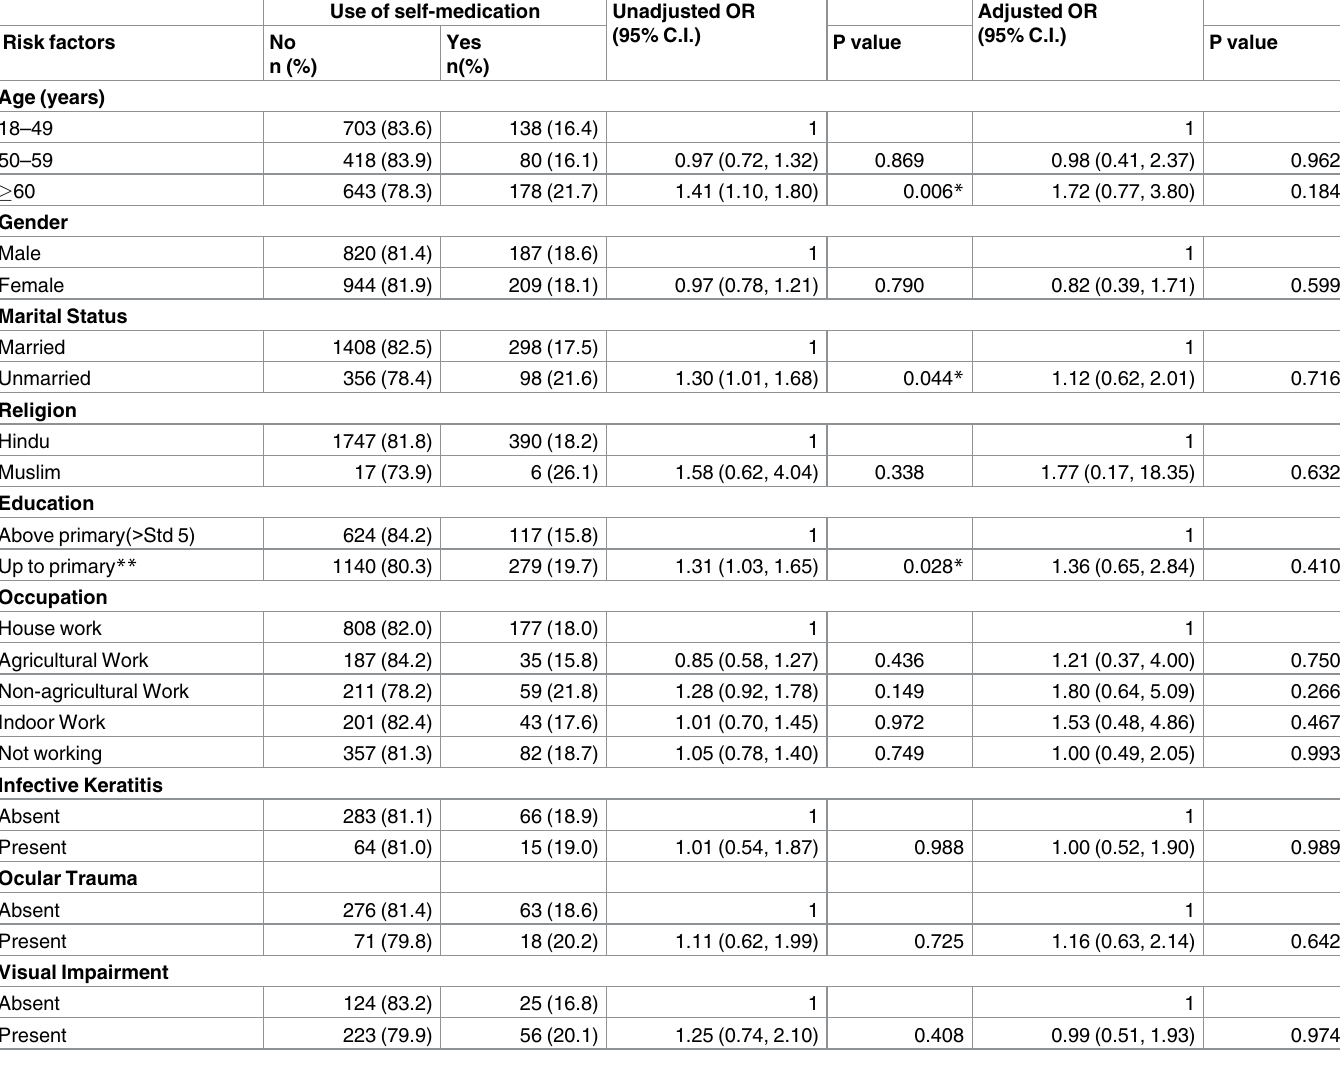
Table 1. Association of socio-demographic and clinical factors with use of self-medication in the study population. Use of self-medication Unadjusted OR (95%